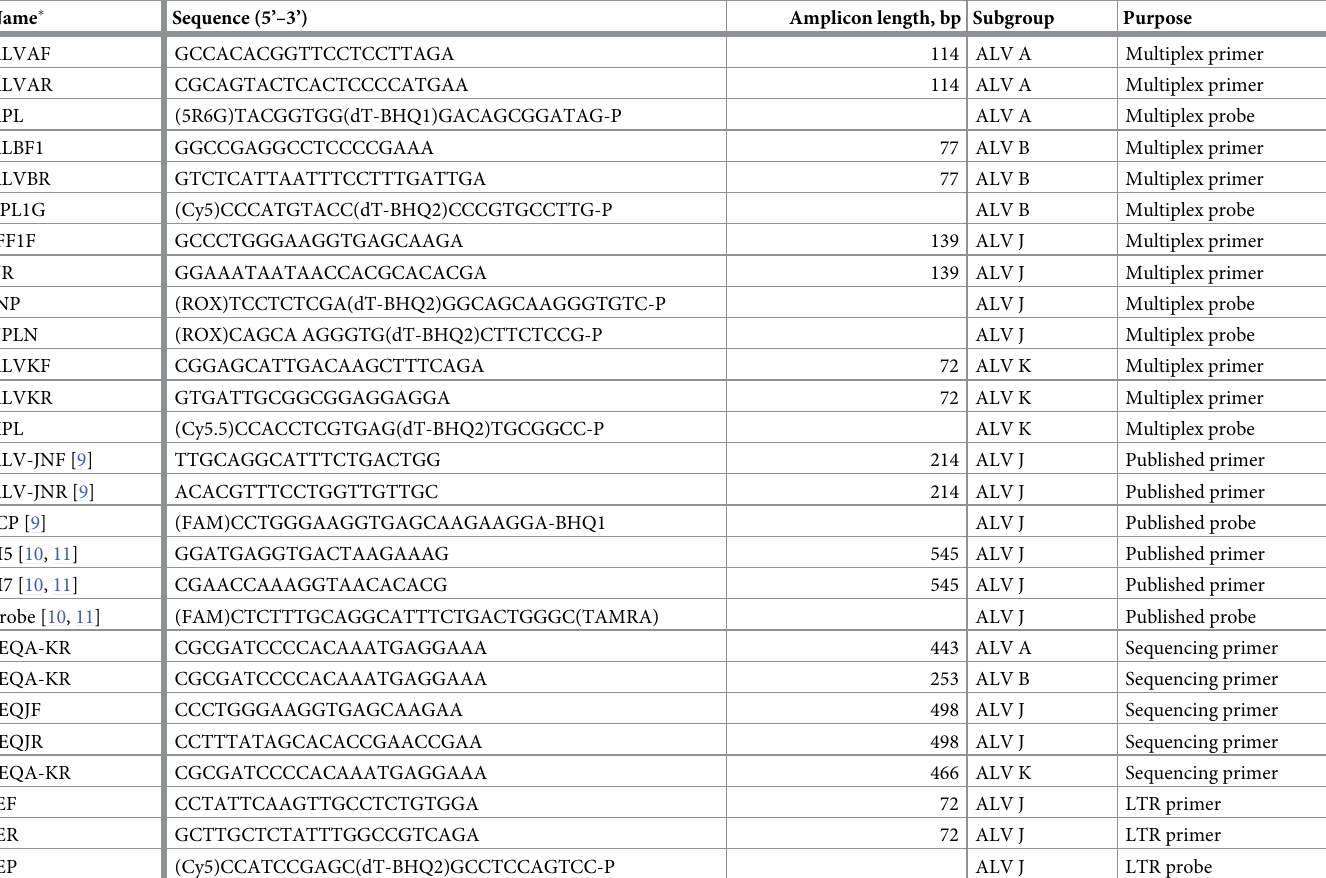
Table 1. Primers and probes used in this